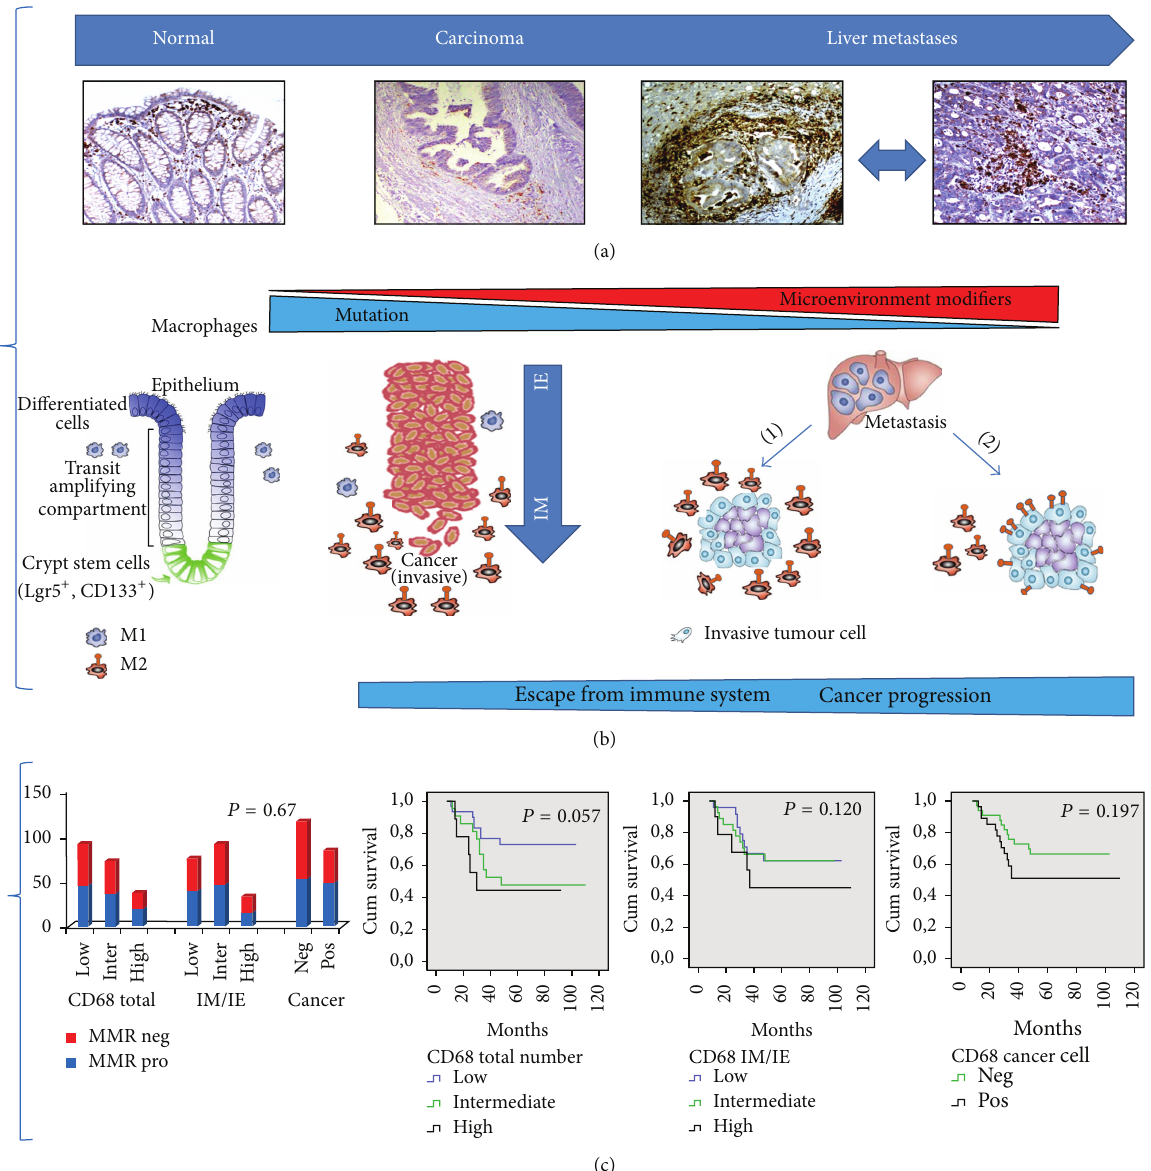
Figure 2: Recruitment of tumour-promoting immune cells contributes to progression and metastasis. (a) Representative images of tissue sections (normal colonic mucosa, carcinoma, and liver metastases) immunostained with CD68, a marker of macrophages with a